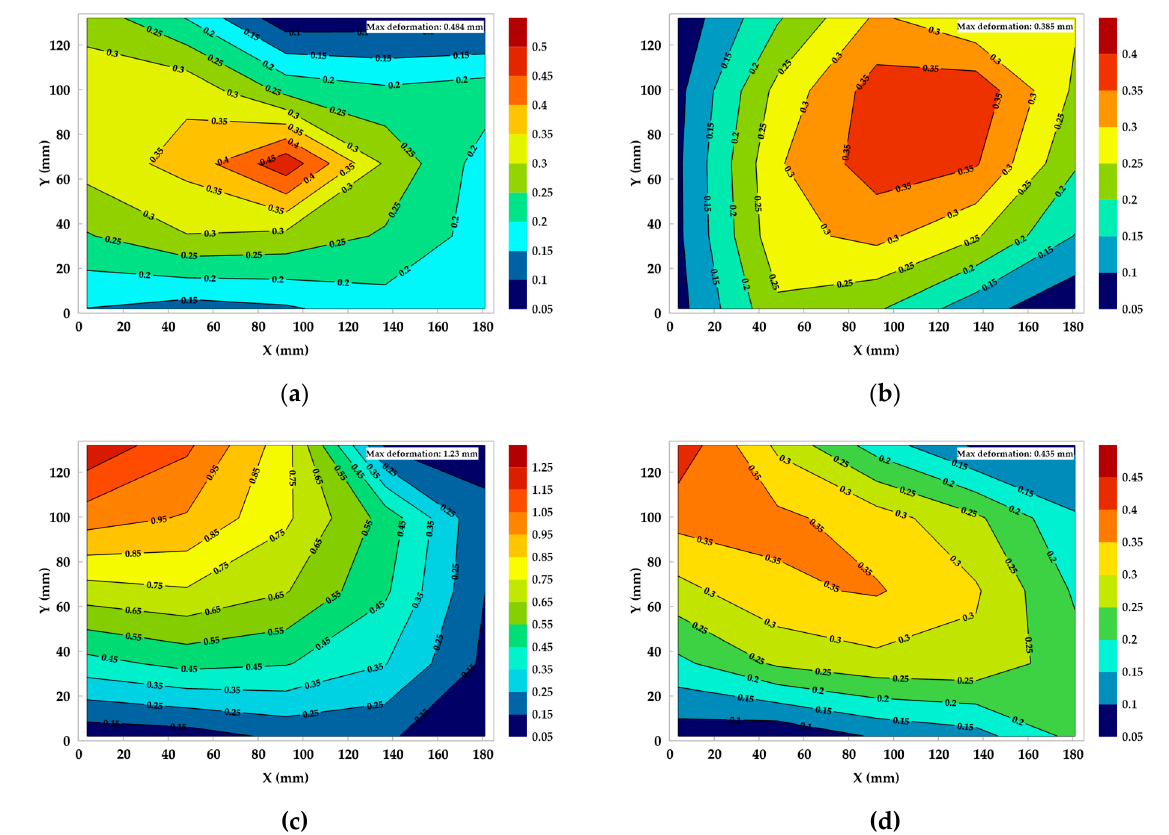
Figure 7. The deformation distribution of experimental groups 1 to 4 (N1). ( a ) A1B1C1D1E1, Max = 0.484 mm. ( b )